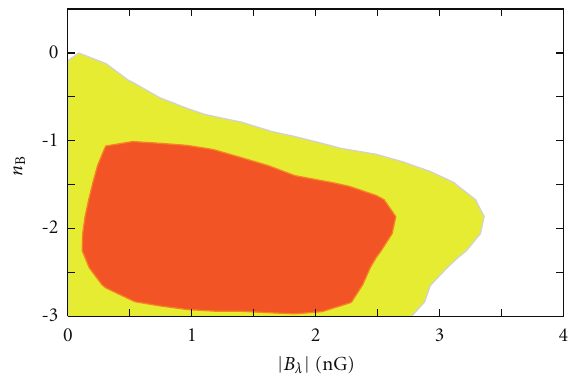
Figure 10: Probability contours in the plane of B λ versus n B . Orange contours show 1 σ (68%) confidence limits, and yellow contours show 2 σ (95%) confidence